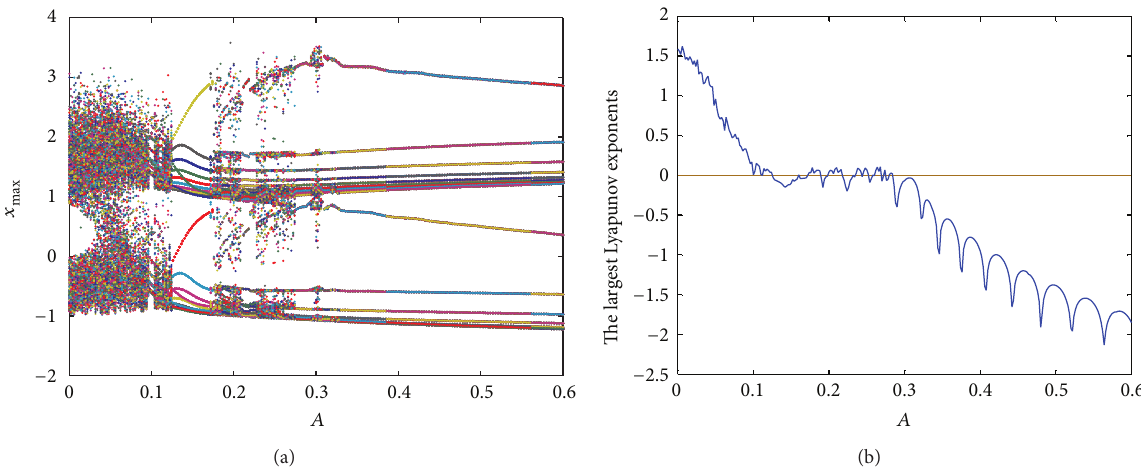
Figure 5: Dynamical behavior of the system (6) with 𝐴 in [0, 0.6] and 𝜔 = 0.6 : (a) bifurcation diagram for increasing 𝐴 ; (b) the largest Lyapunov exponent versus 𝐴 .